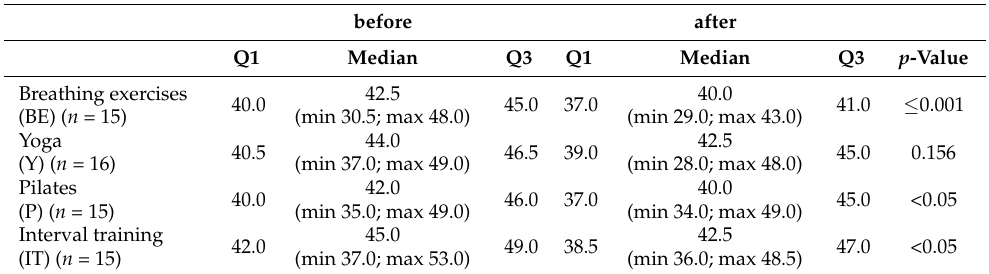
Table 7. Results of the trunk side bending (lateral flexion) test (cm) to the left side in the four groups (target BE programme and three other programmes: yoga, Pilates and dynamic interval training) before and after the training period. The students participated voluntarily in and were randomly assigned to training programmes. The duration of each training session was one hour, twice a week for 7